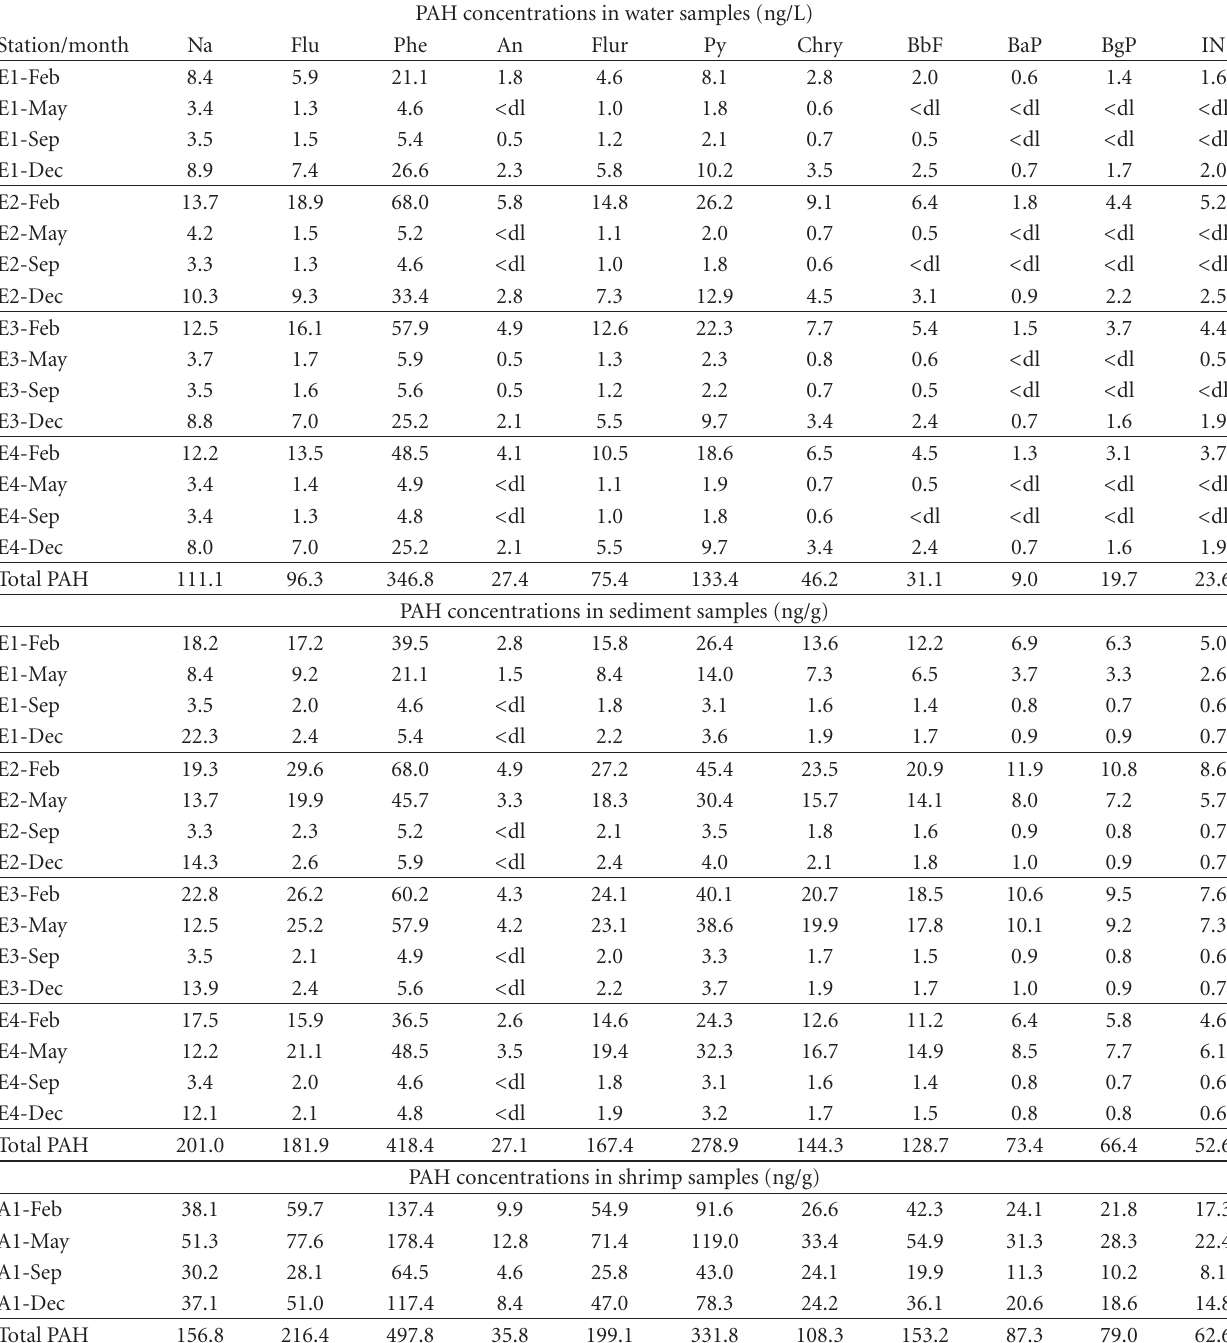
Table 1: Congener specific PAH concentrations in water, sediments, and shrimps. PAH concentrations in water samples